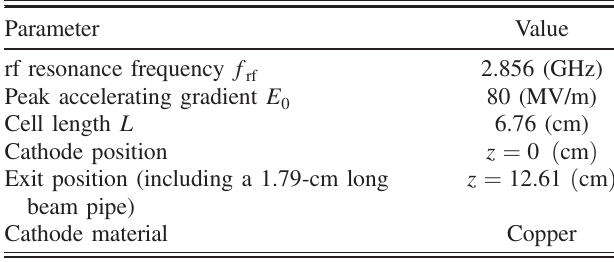
TABLE I. Parameters of the rf photoinjector.